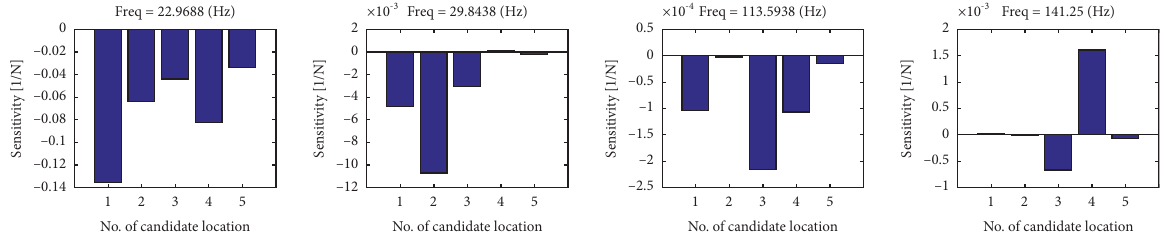
Figure 13: Experimental stifness sensitivity analysis at four chosen frequencies.